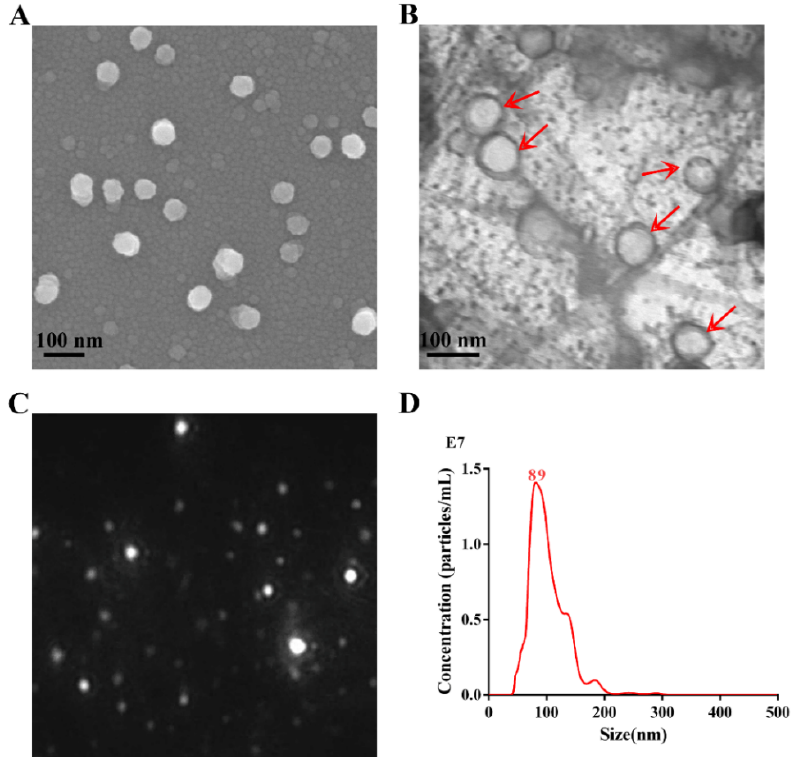
Figure 1. Characterization of outer membrane vesicles secreted by avian pathogenic E. coli O2 (APEC_OMVs). ( A ) The purified APEC_OMVs were viewed with a scanning electron microscope. ( B ) After negative staining with 1% phosphotungstic acid, APEC_OMVs were visualized by transmission electron microscopy. The red arrows indicate several visible APEC_OMVs. ( C ) The image from the movie captured using a SCMOS camera of Malven NTA 3.0 when APEC_OMVs were characterized by nanoparticle tracking analysis (NTA). ( D ) Concentration and size distribution of APEC_OMVs determined by NTA.